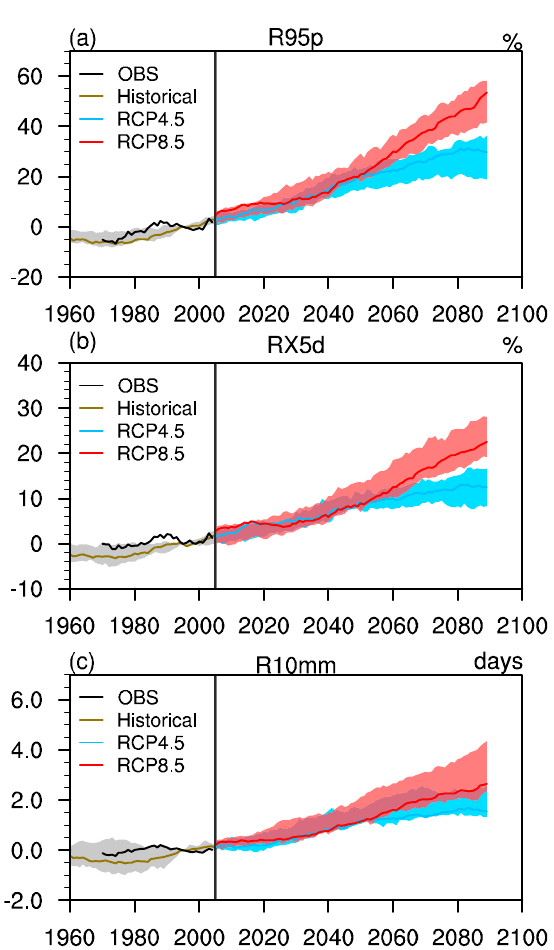
Figure 13. Three extreme rainfall indices including R95p ( a ), RX5d ( b ), and R10mm ( c ) change relative to the reference period (1986–2005) for observation (black), historical simulation (yellow), projection under RCP4.5 (blue), and RCP8.5 (red) from Group 1. Solid lines show the Group 1 average and the shading indicates interquartile AMME spread (25th and 75th quantiles).